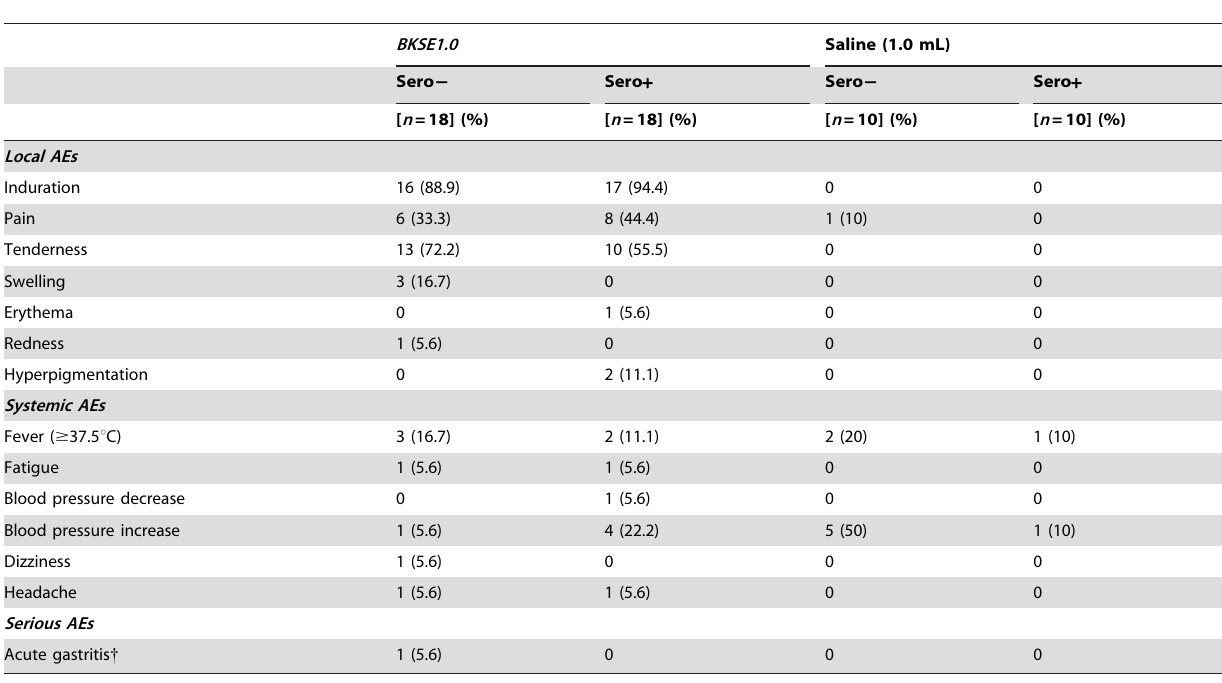
Table 2. Adverse events (AEs) and serious adverse events (SAEs) in seronegative and seropositive adults.